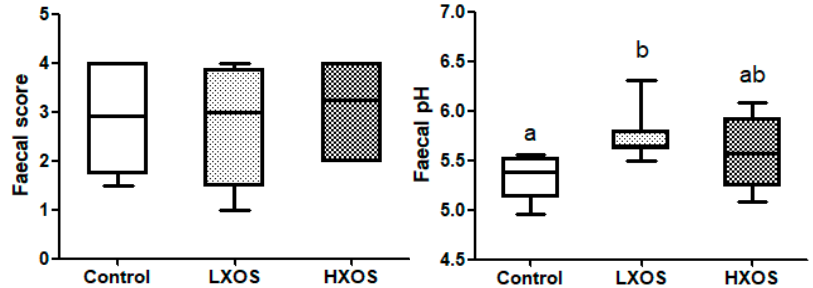
Figure 1. E ff ect of xylooligosaccharides (XOS) on fecal score and pH. Groups with di ff erent letters (a, b) are significantly di ff erent ( p <